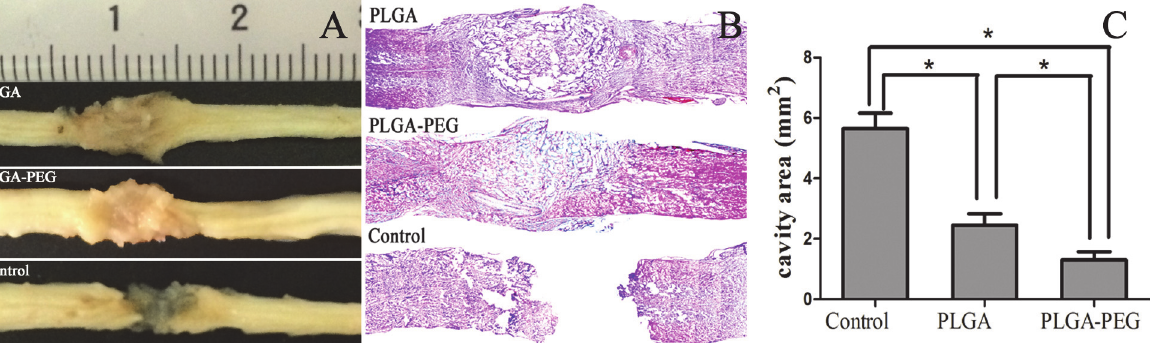
Fig 14. Gross morphology and cavity formation of spinal cord tissue dissected at 8 weeks post-operation. The PLGA and PLGA-PEG nanofibers both contributed to tissue structural integrity, whereas a large gap in the lesion site was still present in the control group (A). In both of PLGA and PLGA-PEG group, cavity areas were reduced compared with control group (B). The smallest cavity area was observed in PLGA-PEG group. However, larger cavities were observed in the PLGA group (P < 0.05, Student t-test, n = 3) (C).